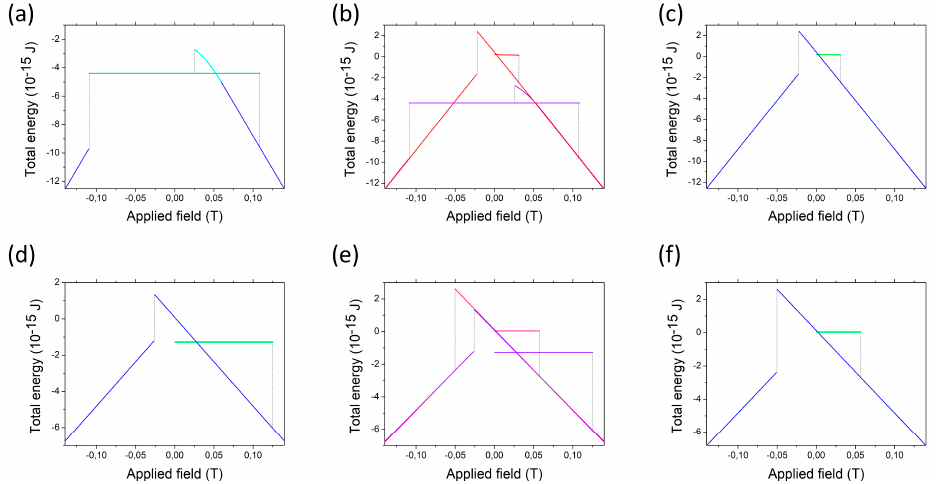
Figure 4. Energies of the subsequent configurations of the models discussed in this section, upper panel: stripes, lower panel: ellipsoids. The leftmost ( a , d ) S-W model, the rightmost ( c , f ) micromagnetic calculations, the central parts ( b , e ) comparison of both.